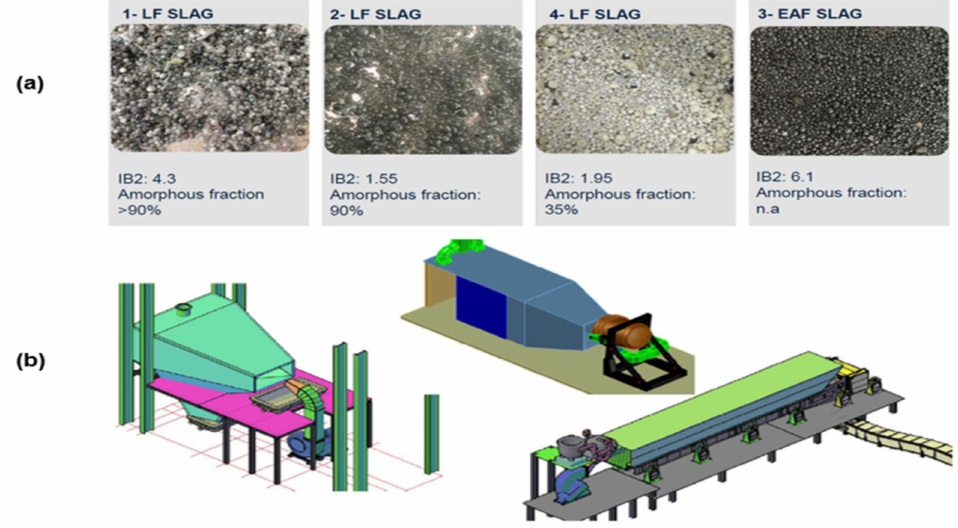
Figure 10. Dry slag granulation results ( a ) and different plant layouts ( b ) [28]. BOF slag has different applications depending on the legal regulations in each EU member state [31]. In Italy, for example, the use of BOF slag for agriculture in Italian soils is being investigated [32]. Italian coastal soils are typically rich in alkalies and might have excess sodium due to intrusions from coastal aquifers and irrigation with saline